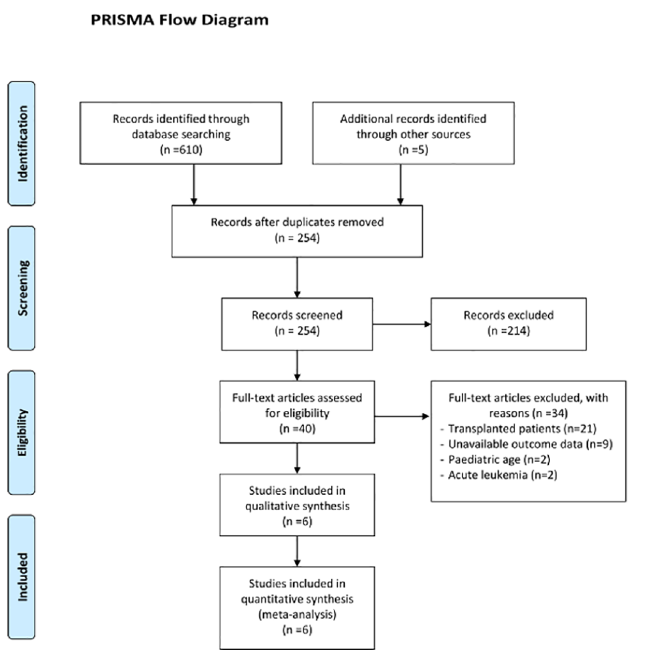
Fig 1. Flow chart of the included studies in the